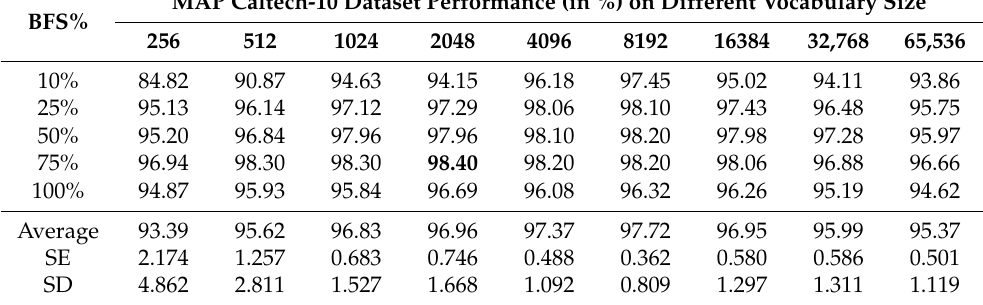
Table 6. The KFFVW Performance with various vocabulary sizes and BFS on the Caltech-10 dataset. BFS%